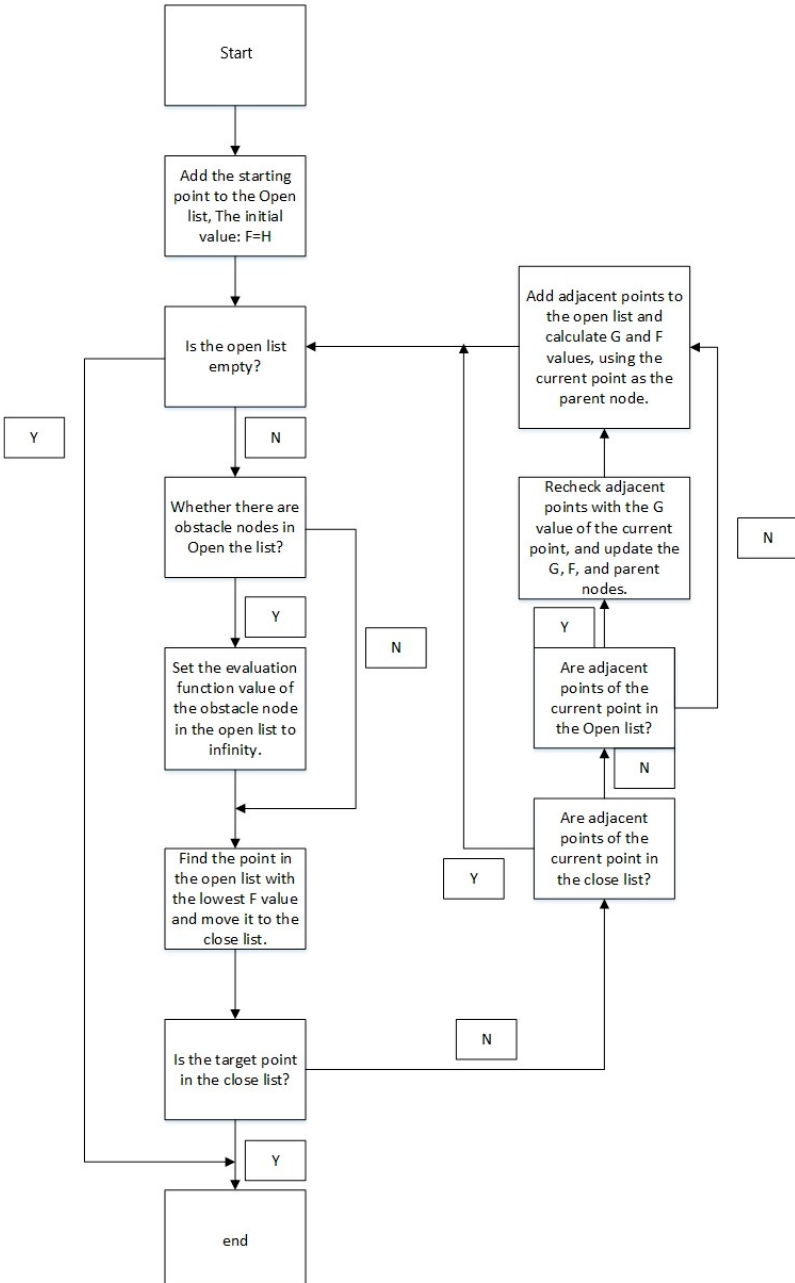
Figure 3. Optimization of the A-star calculation hair path-planning process.